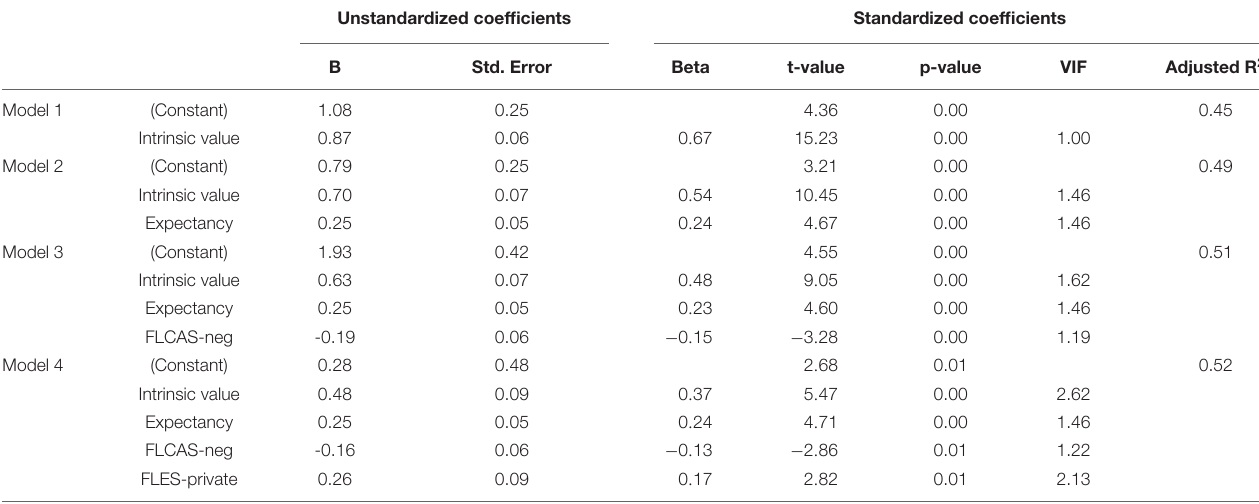
TABLE 4 | Regression models with self-rated FL proficiency as a dependent